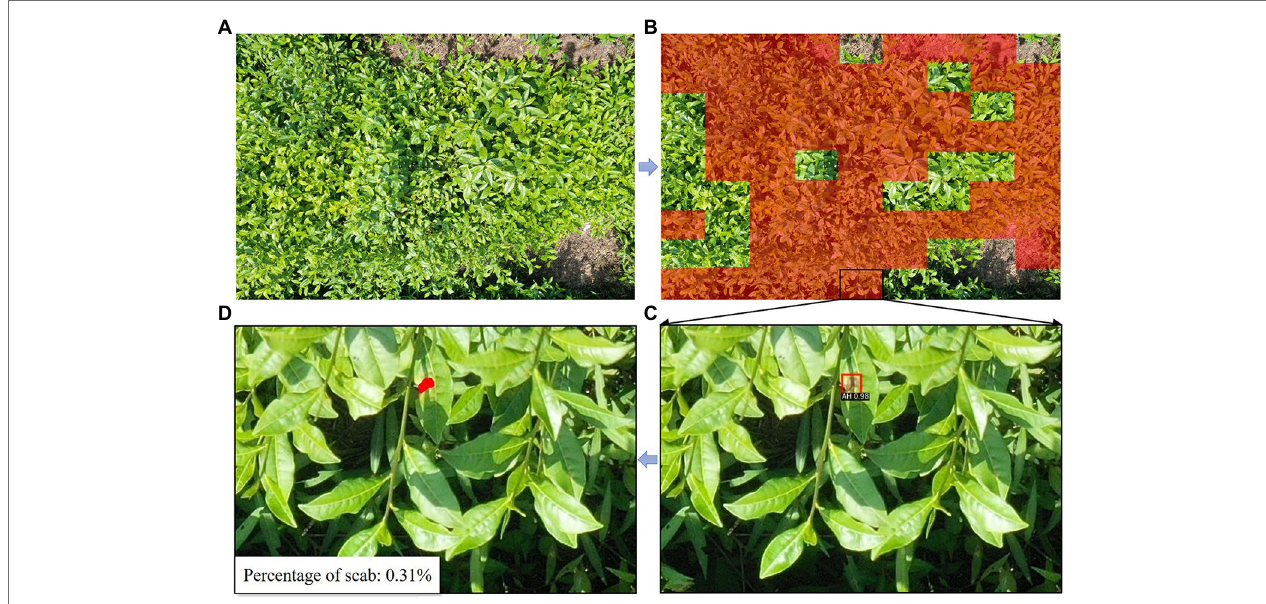
FIGURE 13 | Precise scab detection and labeling in UAV images by transfer learning. (A) The original UAV image; (B) stressed sub-areas highlighted in red; (C) sub-image with stressed area labeled in a box; and (D) sub-image with an exact boundary of stressed